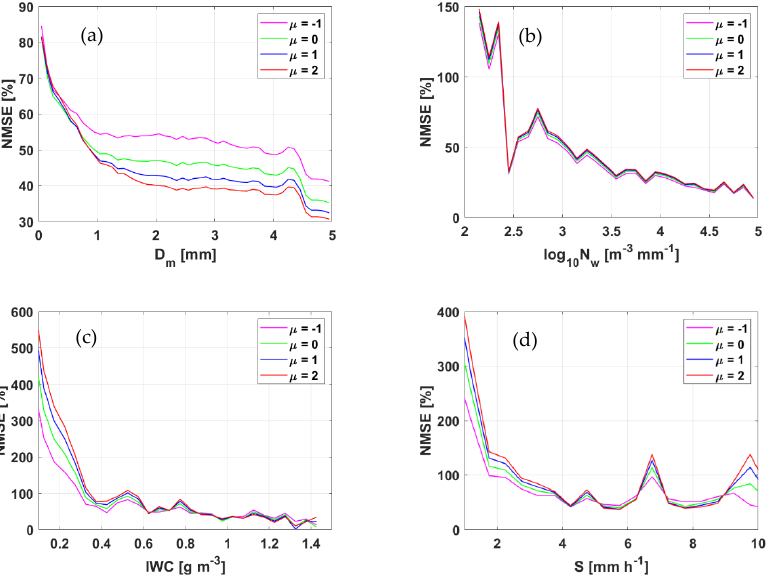
Figure 4. The absolute error normalized to the mean of D m ( a ), N w ( b ), IWC ( c ), and S ( d ) when the µ values are − 1, 0, 1, and